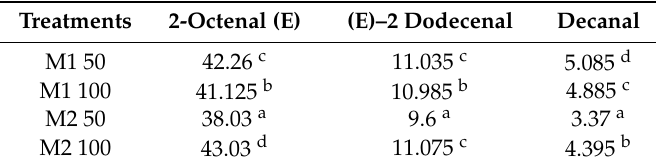
Table 4. Percentage of each compound with respect to the total of detected compounds.